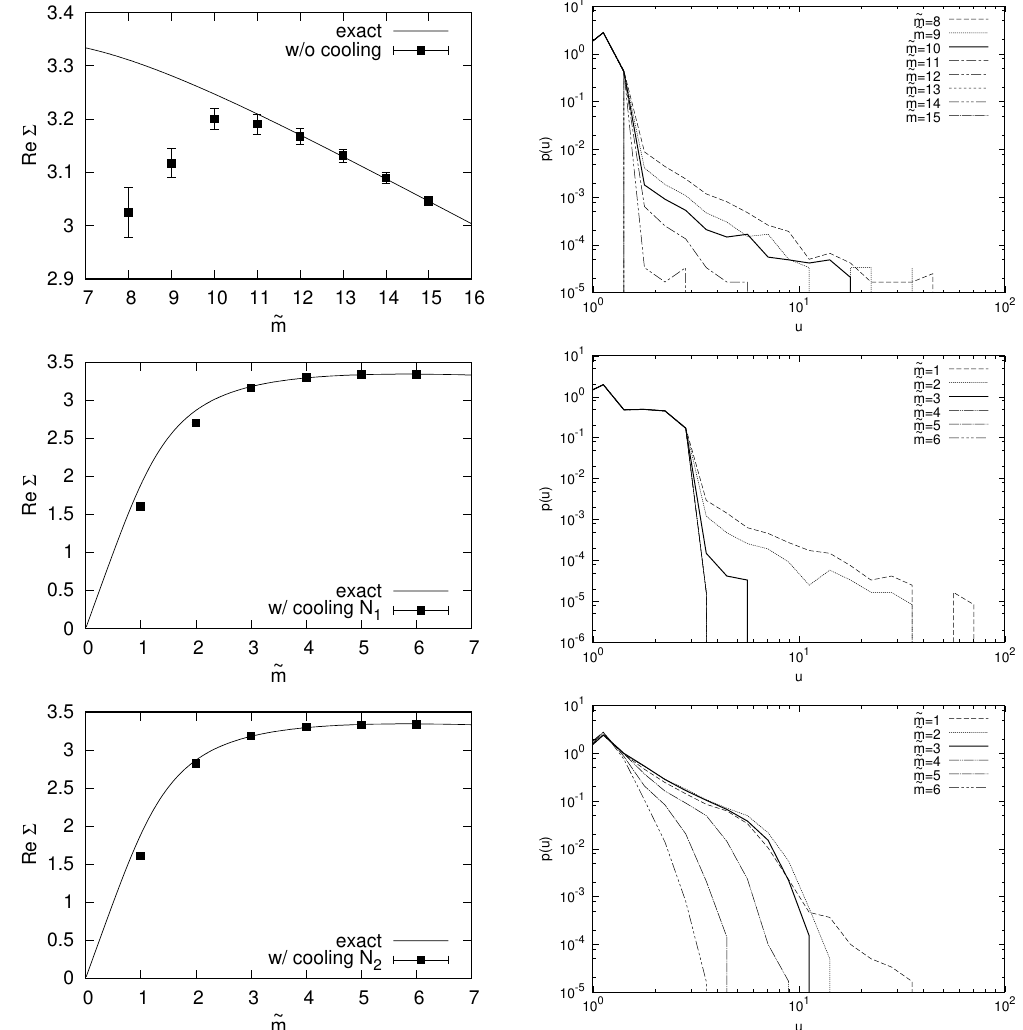
Figure 2 . (Left) The real part of the chiral condensate is plotted against ~ m for the cases without gauge cooling (Top) and with gauge cooling using the norms ^ N 1 (Middle) and ^ N 2 (Bottom). (Right) The probability distribution (4.13) of the drift term is shown in log-log plots for each